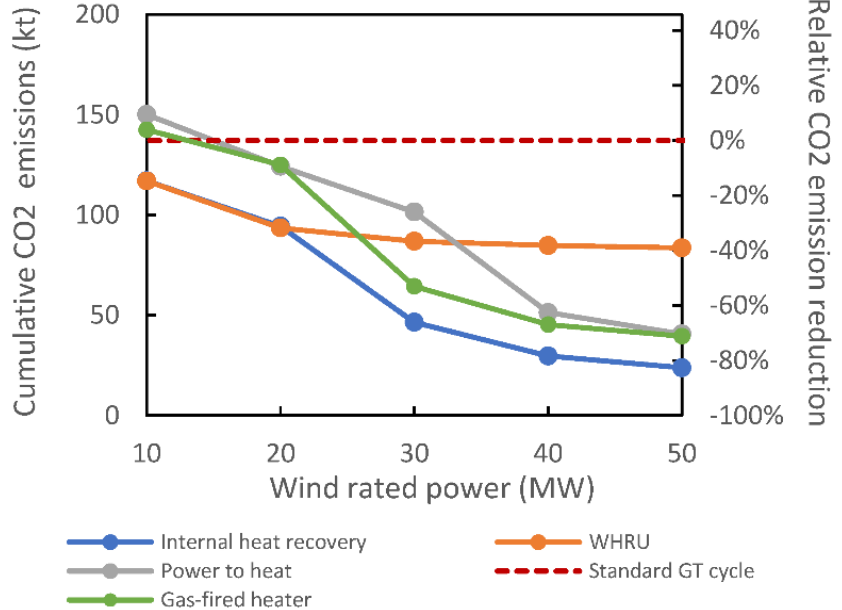
Figure 2. Absolute and relative CO 2 emissions for the different configurations analysed.